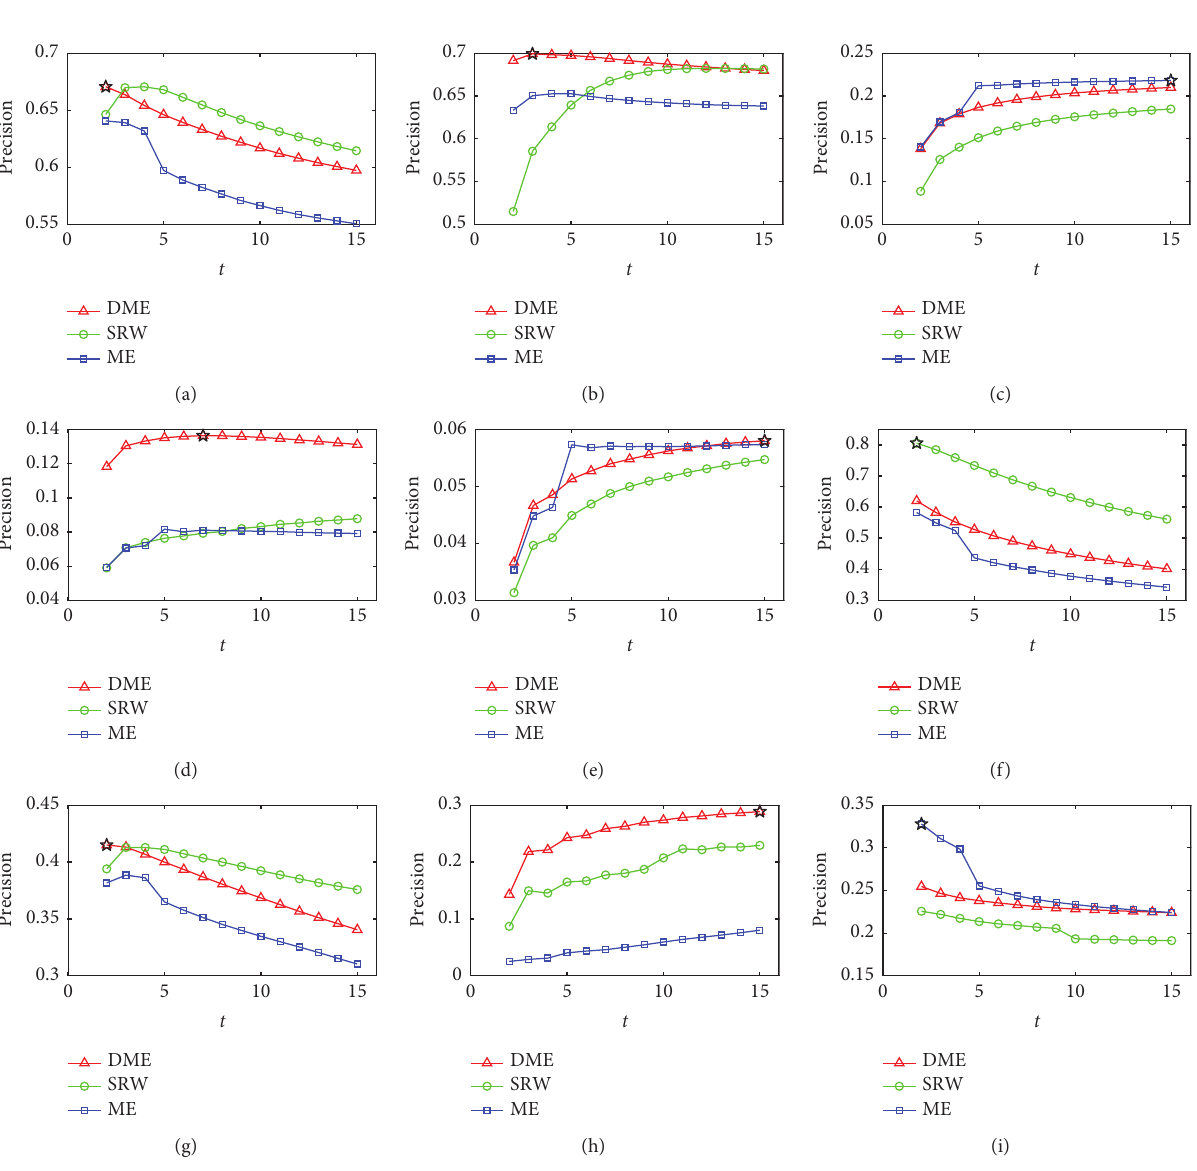
Figure 2: Precision of SRW (green circles), ME (blue rectangles), and DME (red triangles) versus number of random walk steps t with L � 100 in 9 real datasets. The highest precision in each network is marked by a black five-angled star. As is shown, DME performs better obviously in 8 of the 9 networks than SRW. Furthermore, compared to SRW and ME models, the DME model achieves the maximum